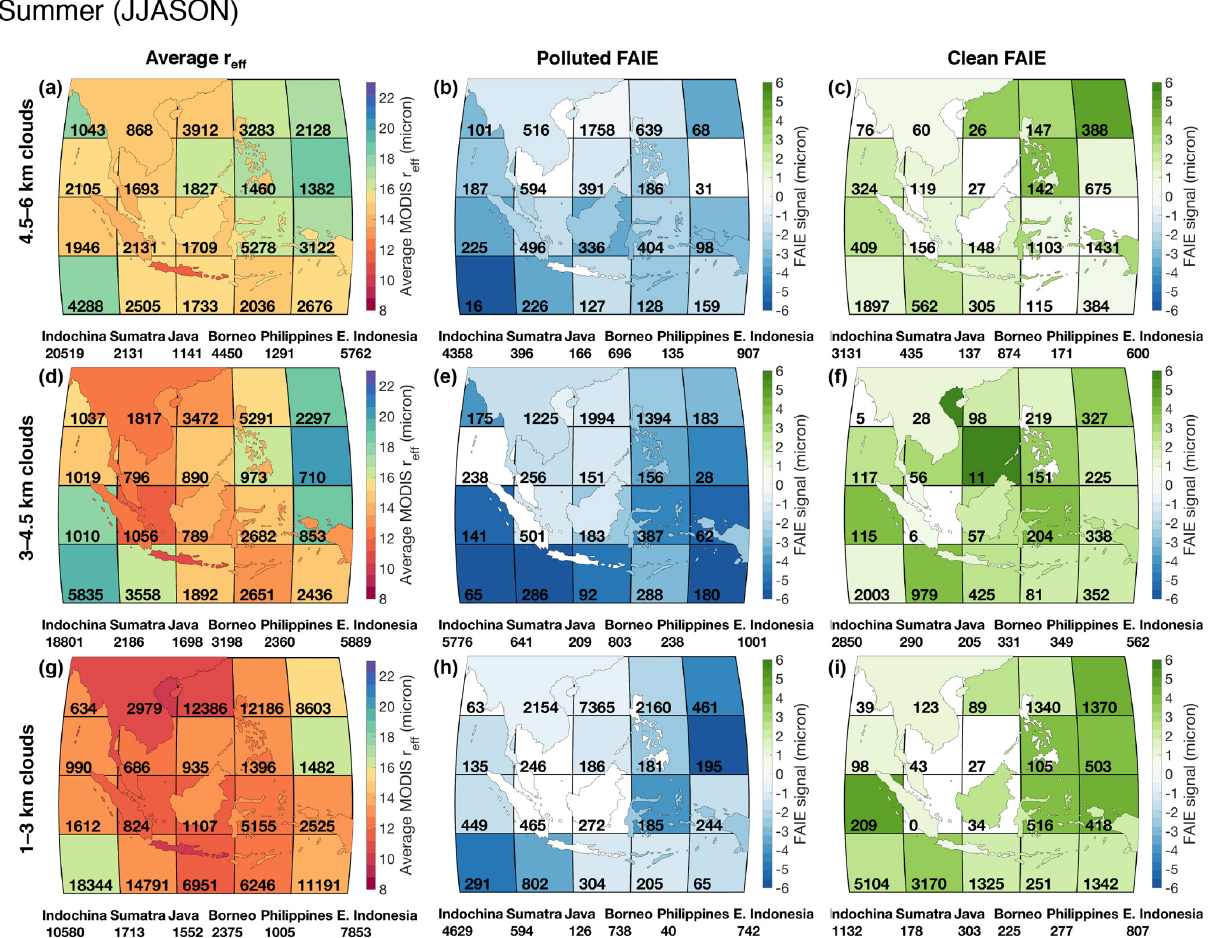
Figure 9. Maps illustrating average baseline r eff and significant polluted and clean FAIE signals. The black bolded numbers signify the count of the cloud populations. Summer months June through November are shown here. The columns from left to right show the average bulk (or baseline) r eff , significant polluted FAIE, and significant clean FAIE. The rows from bottom to top show cloud top height regimes: clouds between 1 and 3, 3 and 4.5, and 4.5 and 6km. Polluted and clean FAIE signals are shaded only if the significance t -test between baseline and anomalous r eff populations yields a p